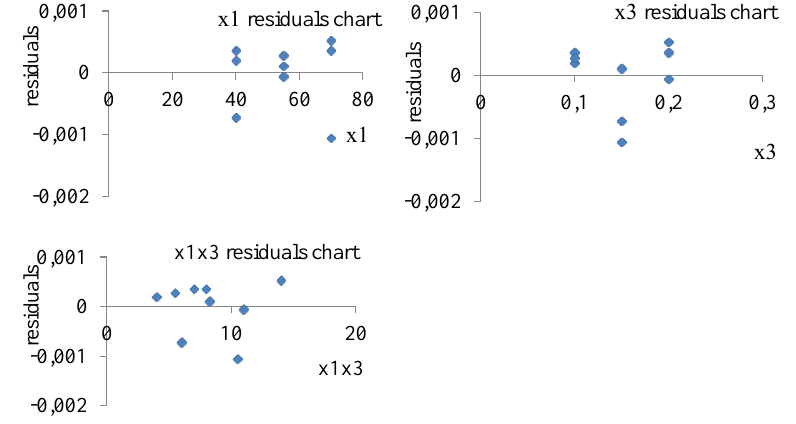
Fig. 2. Plot of residuals as functions of variables